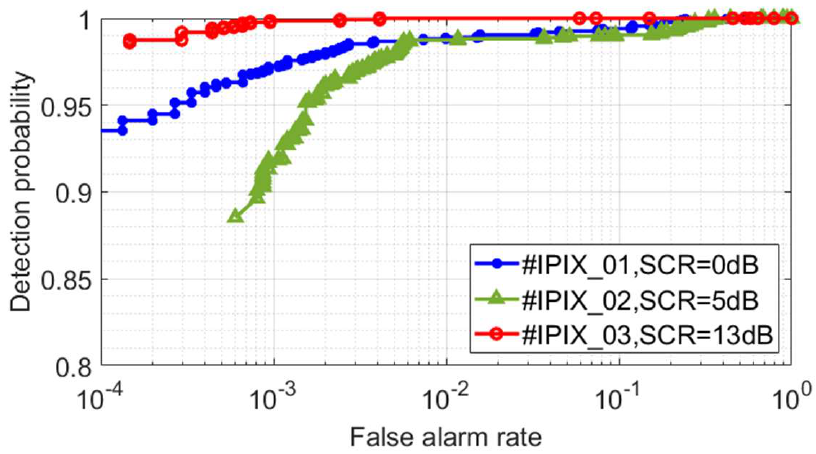
Figure 7. The detection probability of the proposed model under different SCR sea state data. The detection results are obtained from the testing samples and the radar observation time is 0.512 s.